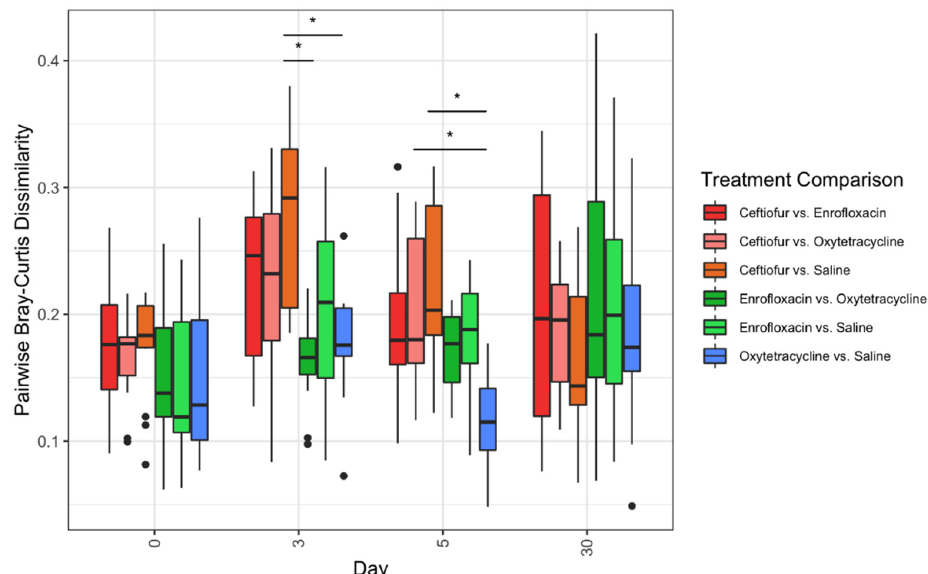
Figure 3. Pairwise Bray-Curtis dissimilarities between treatments by day. Bray-Curtis dissimilarities were measured at genus level taxonomic grouping and stratified by day. Data presented as median and interquartile range (IQR). Whiskers are 1.5 × IQR and data outside the whiskers are shown as outliers (black circles). Asterisks indicate statistically significant differences ( p < 0.05) within the same day.